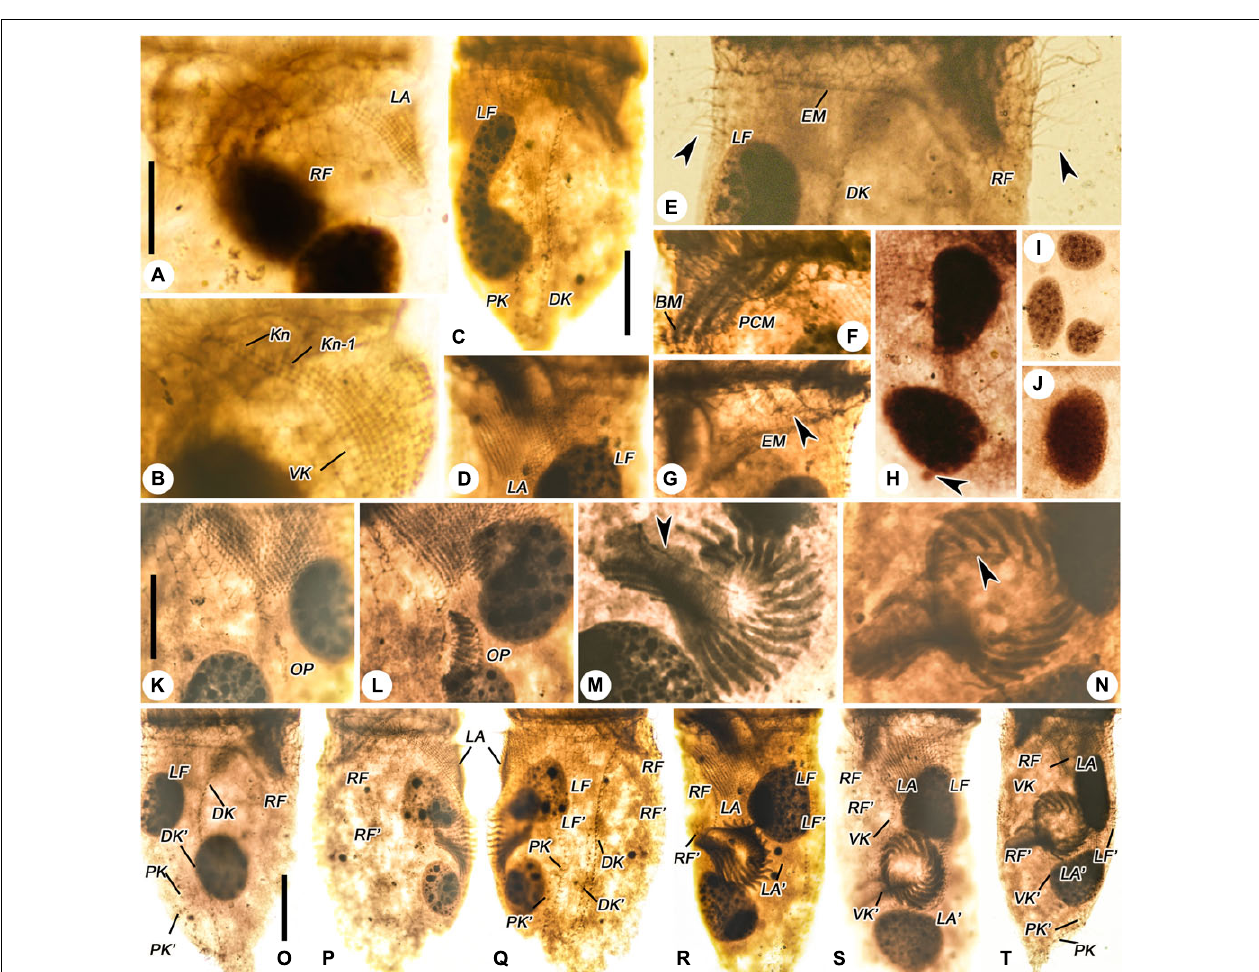
FIGURE 3 | Leprotintinnus nordqvisti after protargol staining. (A,B) Ventrolateral view showing the ventral kinety, right ciliary field, and lateral ciliary field. (C) Dorsal view of an anterdivider, showing left ciliary field, dorsal and posterior kineties. (D) Lateral ciliary field and left ciliary field. (E) The anterior portion of dorsal kinety, left ciliary field, and right ciliary field, arrows indicate the elongated anterior cilia of the right and left ciliary fields. (F) Prolonged collar membranelles and buccal membranelle. (G) Arrowhead shows the endoral membrane. (H–J) Macronuclear nodules and micronuclei (arrowhead). (K,L) Ventral view of early dividers. (M,N) Oral primordium, arrows indicate opisthe’s endoral membranelle. (O) Dorsal view of the same very early divide. (P,Q) Ventral and dorsal views of the same early middle divide. (R) Ventral view of the middle divider. (S) Ventral view of the late middle divide, showing the split of the ventral kinety. (T) Ventral view of the middle-to-late divider. BM, buccal membranelle; DK, DK (cid:48) , proter’s and opisthe’s dorsal kineties; EM, endoral membranelle; LA, LA (cid:48) , proter’s and opisthe’s lateral ciliary fields; LF, LF (cid:48) , proter’s and opisthe’s left ciliary fields; OP, oral primordium; PCM, prolonged collar membranelles; RF, RF (cid:48) , proter’s and opisthe’s right ciliary fields; VK, VK (cid:48) , proter’s and opisthe’s ventral kineties. Scale bars: 20 µ m.